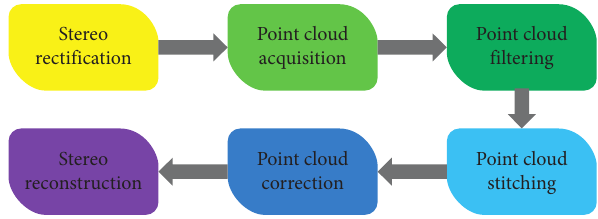
Figure 1: Algorithm flow